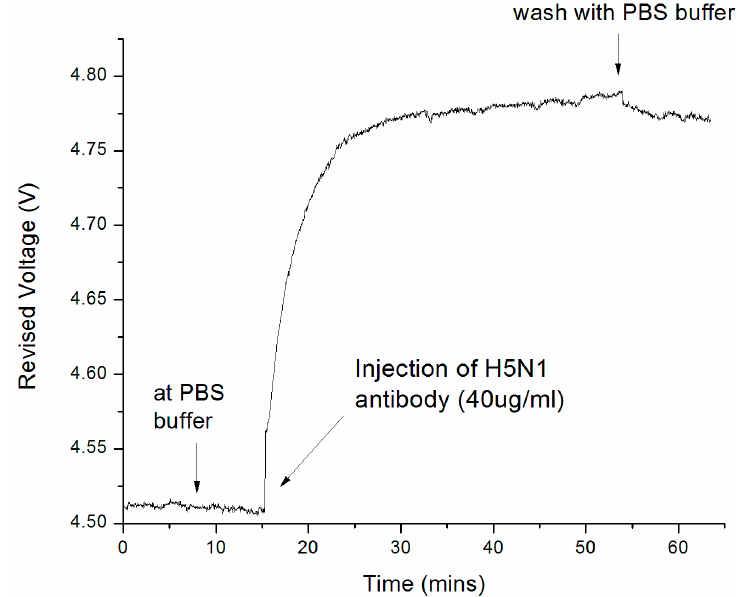
Figure 5. Measurement results for H5N1 antibody detection with the phase-intensity surface plasmon resonance biosensor (each data point is averaged from 10 readings). The detection resolution was found to be 193.3 ng mL − 1 , which is 517.3% [33] and 258.7% [32] greater than that reported in the literature on the influenza antibody detection, with commercial Biacore systems: Biacore 3000 [33] and Biacore T100 [32] were used in the measurement (further information is provided in Appendix A, Figures A1 and A2).